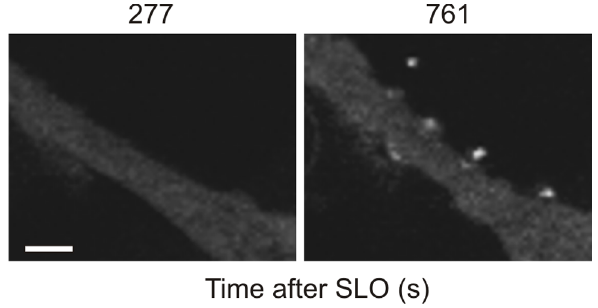
Figure 1. Plasmalemmal repair in SLO-damaged cells is accomplished by the expulsion of microvesicles. Shedding